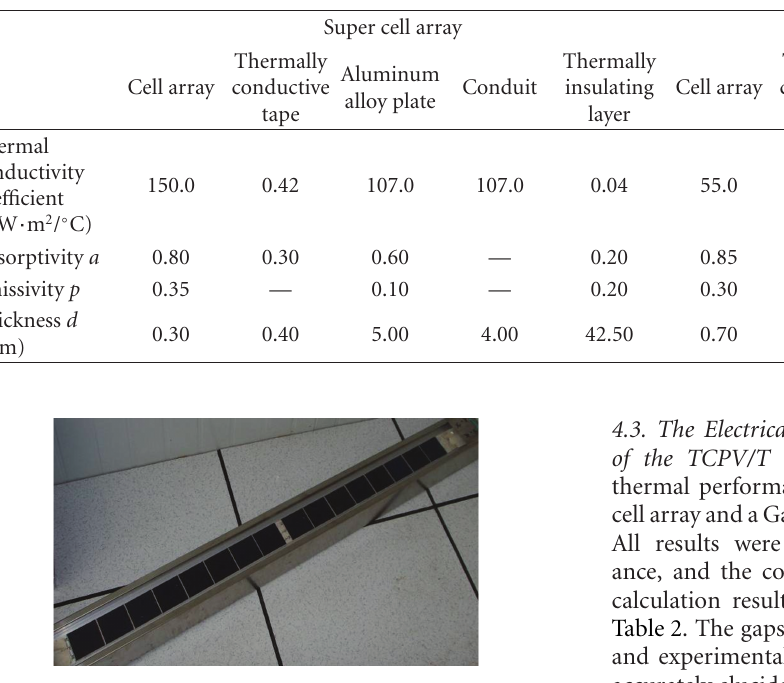
Figure 4: The photograph of the super cell